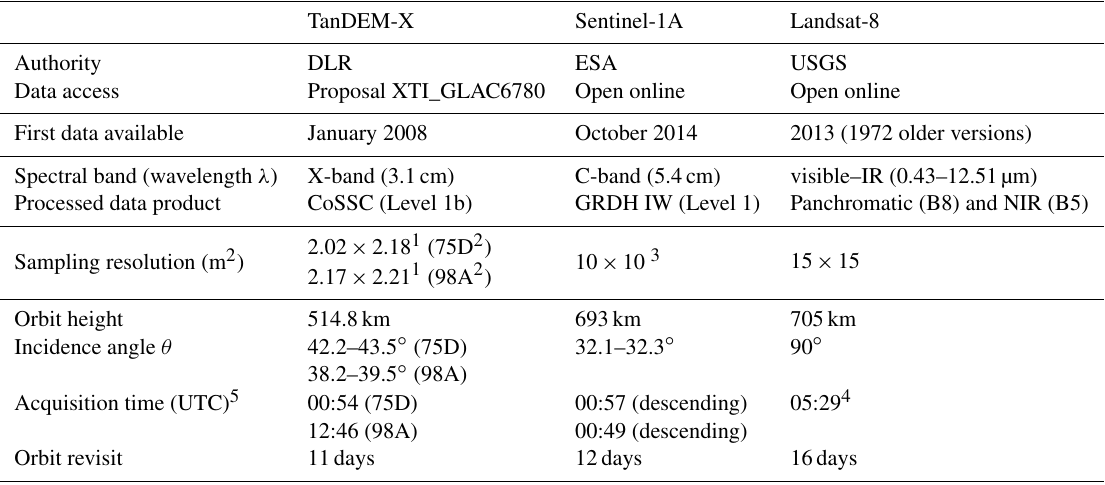
Table 1. Summary of data products acquired by the three listed satellite systems used for this study.